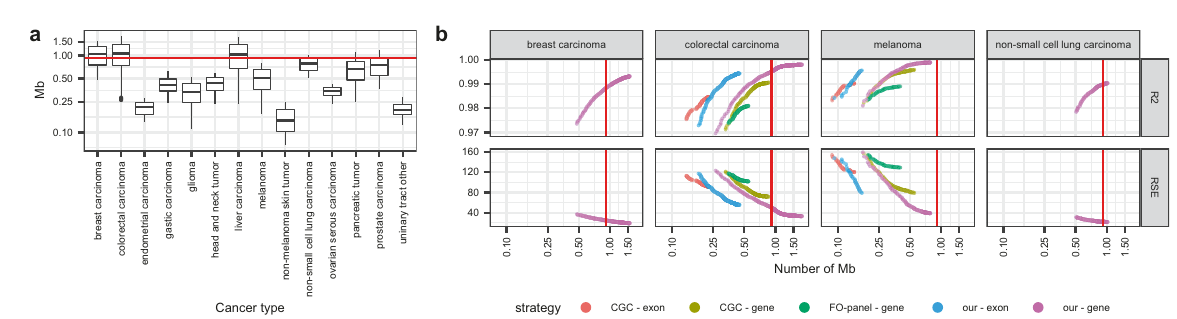
Fig. 2 Characteristics of the panels for TMB prediction. a Size (in Mb). The red line indicates the size of the FO-panel. The center line in the boxes corresponds to the median, the bounds of the boxes to the fi rst and third quartiles, and the whiskers extend to the largest and lowest values no further than 1.5 times the inter-quartile range. Data beyond the end of the whiskers are called “ outlying ” points and plotted individually. b R 2 and RSE of the panels vs. size (in Mb). Only 4 representative cancer types are shown; breast carcinoma, colorectal carcinoma, melanoma, and non-small cell lung carcinoma (for other tumors, see Supplementary Fig. 4). The red line indicates the size of the FO-panel. Each dot represents a model, colors indicate initial